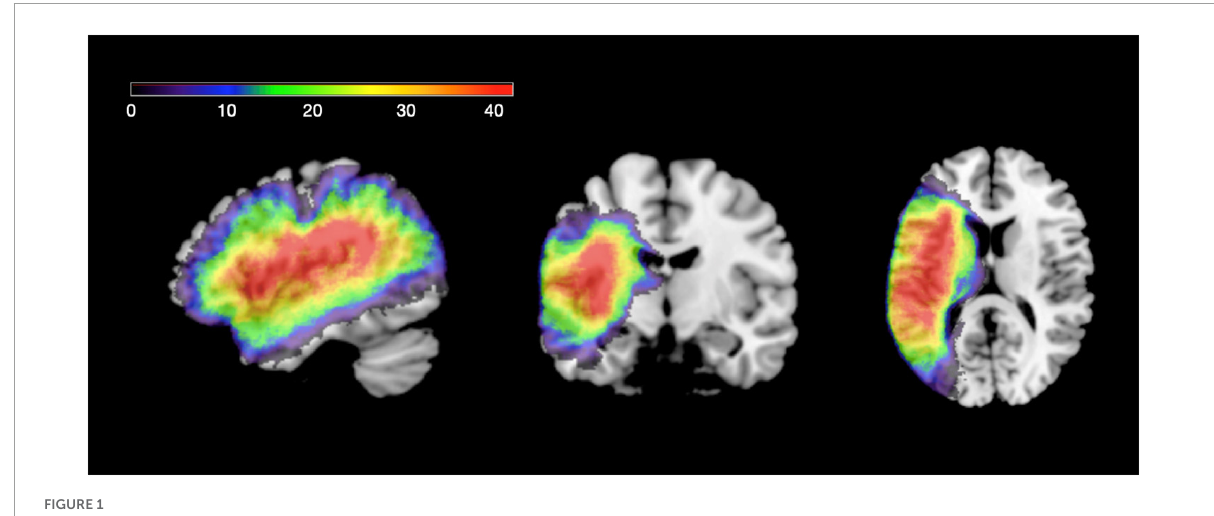
FIGURE1 Lesion overlap for individuals with acquired language